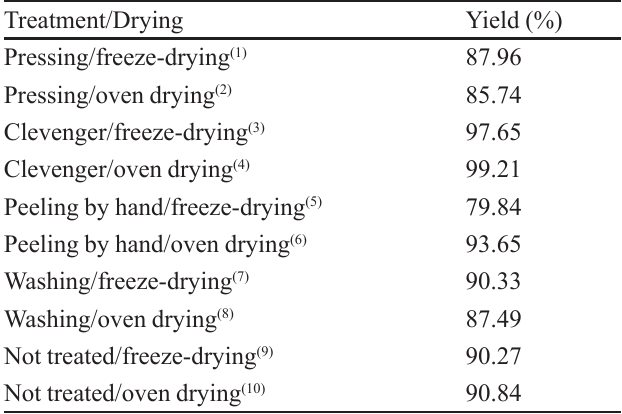
size, for the samples subjected to different treatments and drying processes. TABLE I - Yield, as percentage values, of byproduct aliquots subjected to different treatments and drying processes, retained sieves with mesh size of between 500 and 125 m m